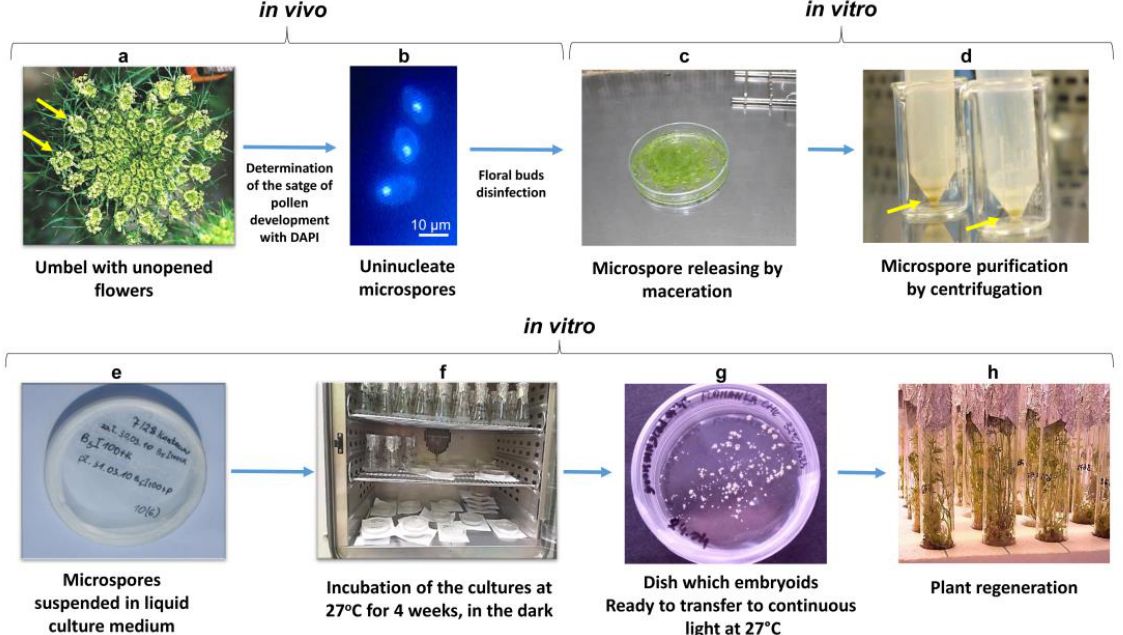
Figure 3. Steps in obtaining androgenetic carrot plants in isolated microspore cultures. Blue arrows indicate transition between the steps. ( a ) Umbel of the donor plant, with arrows marking the umbels containing optimal buds to androgenesis; ( b ) uninucleate microspores of carrot after 4,6-diamino-2- phenylindole (DAPI) staining; ( c , d ) microspore release and purification, where the arrows in picture ‘d’ show microspores collected in the pellet; ( e , f ) culture of carrot microspores incubated in the dark at 27 °C; ( g ) young embryoids visible with the naked eye after approximately 4 weeks of culture; ( h ) microspore-derived carrot plantlets at the regeneration stage.